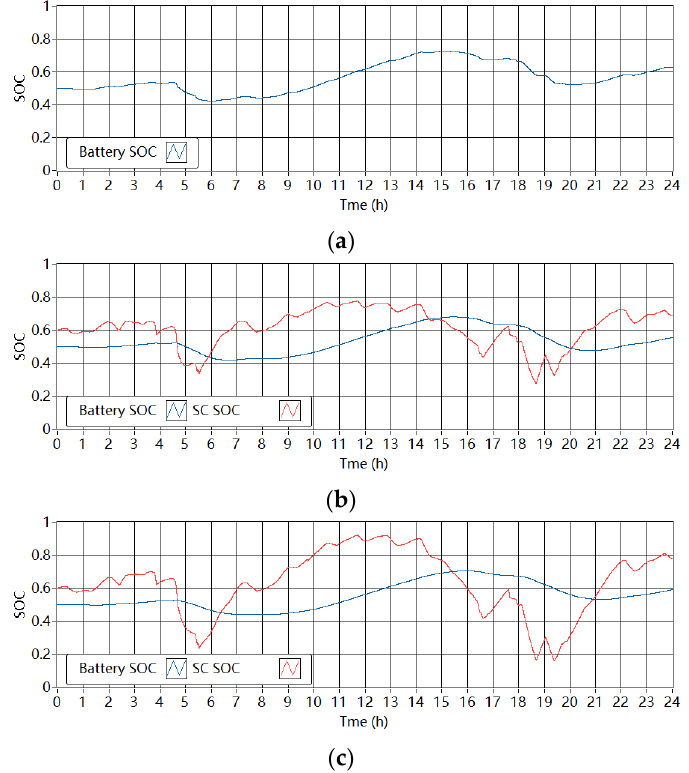
Figure 14. SOC of ESDs in the experimental setup in the wind-powered system. ( a ) Single-battery ESS. ( b ) Battery-SC HESS when T f is 1800 s. ( c ) Battery-SC HESS when T f is 3600 s.